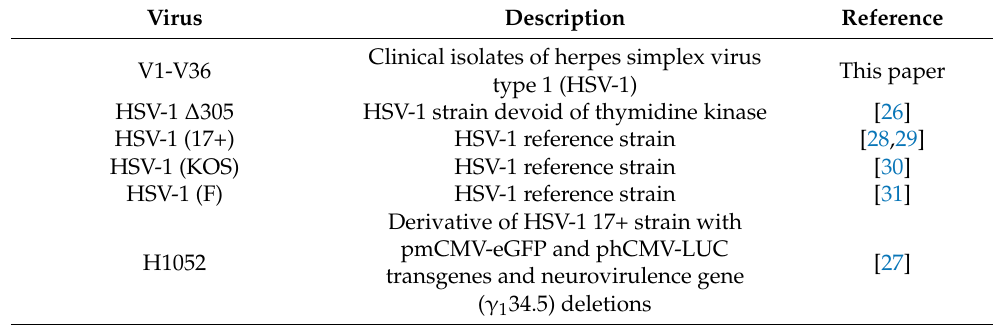
Table 2. Viruses